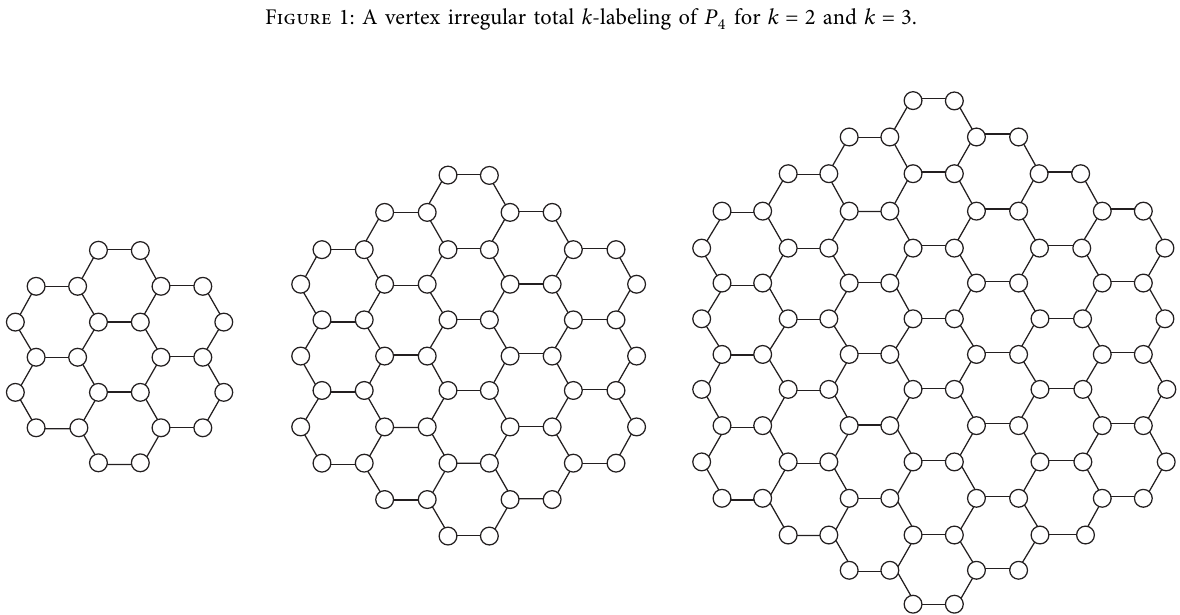
Figure 2: Hexagonal cluster graphs HC ( 2 ) , HC ( 3 ) , and HC ( 4 ) .